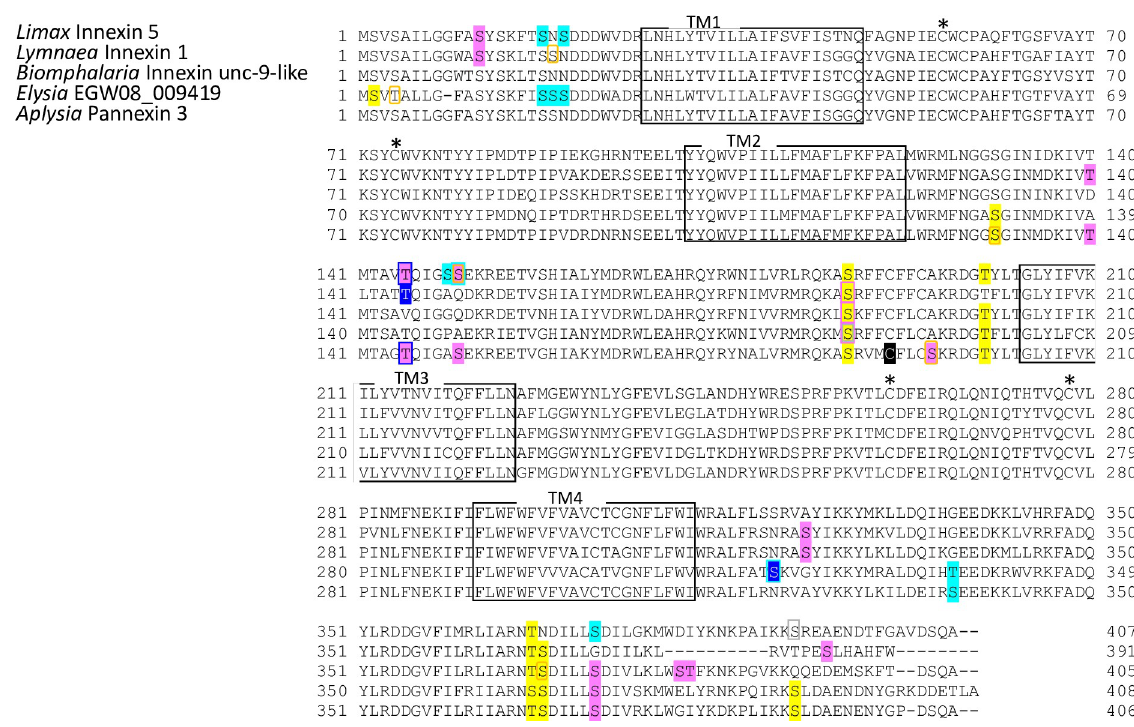
Fig 5. Protein sequence alignment of molluscan innexin orthologs in Group 3. Alignment of deduced amino acid sequences of Limax innexin 5 with orthologous innexin sequences. The boxes show the four transmembrane domains, while the asterisks indicate the extracellular cysteine residues. The potential S-nitrosylation sites are shaded in black. The phosphorylation sites are indicated with shading or box in magenta (protein kinase C), yellow (protein kinase A), blue (casein kinase 1), cyan (casein kinase 2), orange (P34cdc2), and gray (protein kinase